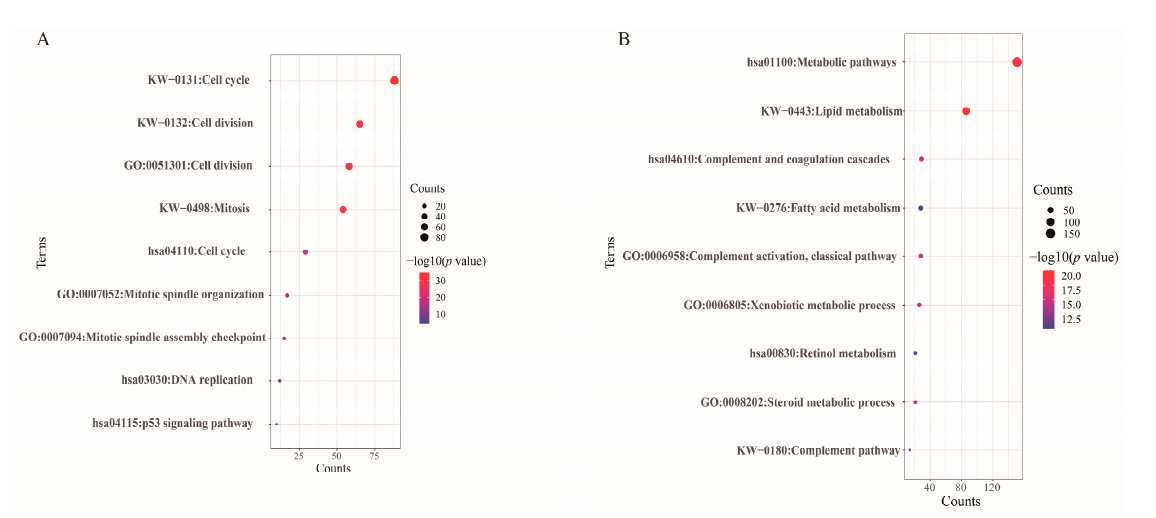
Figure 2. KEGG pathway and biological process enrichment analyses of 1312 DEGs from the GSE102079 dataset. ( A ) KEGG pathway and biological process enrichment analyses of 578 upregulated DEGs. ( B ) KEGG pathway and biological process enrichment analyses of 734 downregulated DEGs. In these bubble charts, the y -axis labels present enriched the top 3 terms of KEGG pathway, UniProt KW biological process, and GO biological process analyses. The x -axis labels present gene counts, which represent the number of DEGs enriched in a KEGG pathway term or a biological process term. The bubble sizes represent gene counts, and color intensity represents -log10 ( p values) of the significantly enriched terms. Abbreviations : KEGG, Kyoto Encyclopedia of Genes and Genomes; KW, Keywords; GO, Gene Ontology.